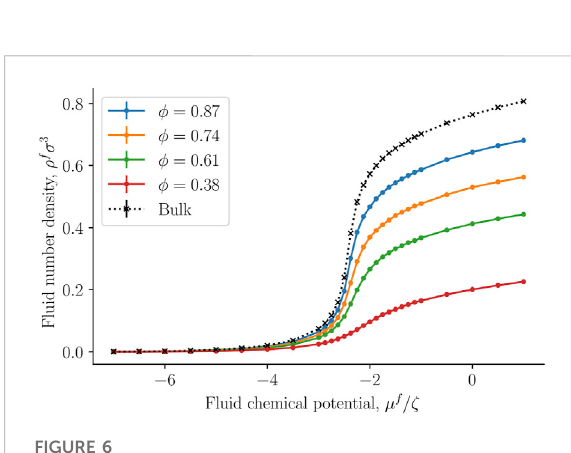
FIGURE 4 Surface tension for the single-sphere case γ as a function of fl uid chemical potential μ f .